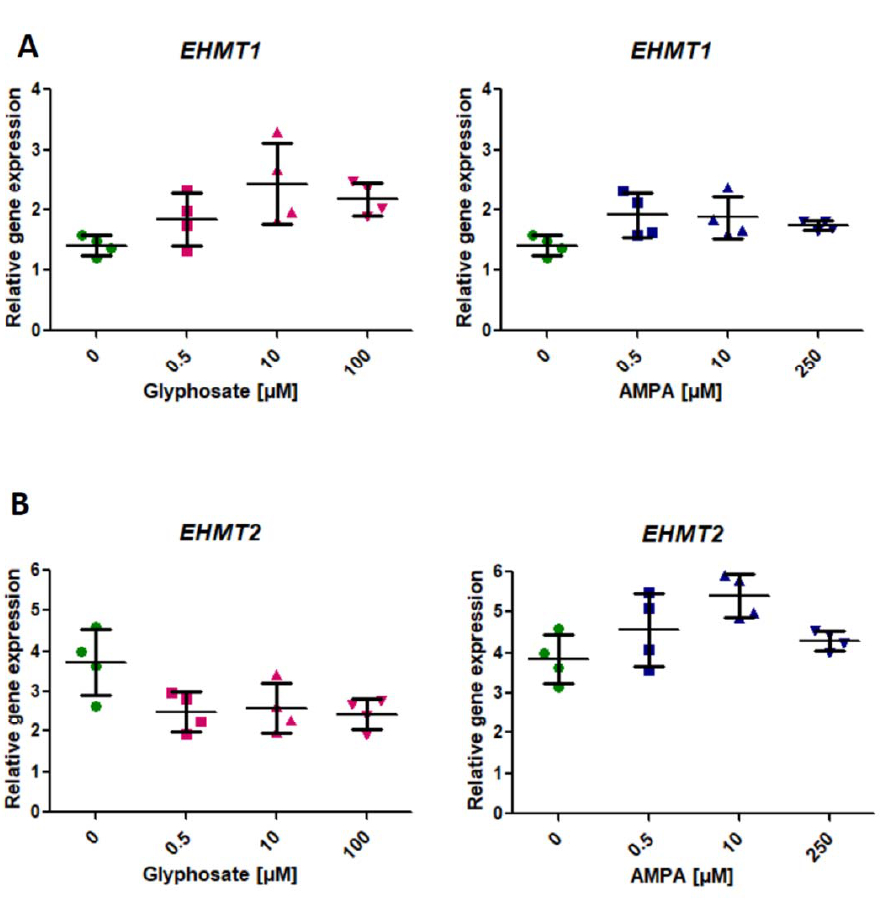
Figure 2. Expression of genes involved in histone methylation—EHMT1 ( A ), EHMT2 ( B ) in human PBMCs incubated with glyphosate (0.5–100 µ M) and AMPA (0.5–250 µ M) for 24 h. Mean ± SD